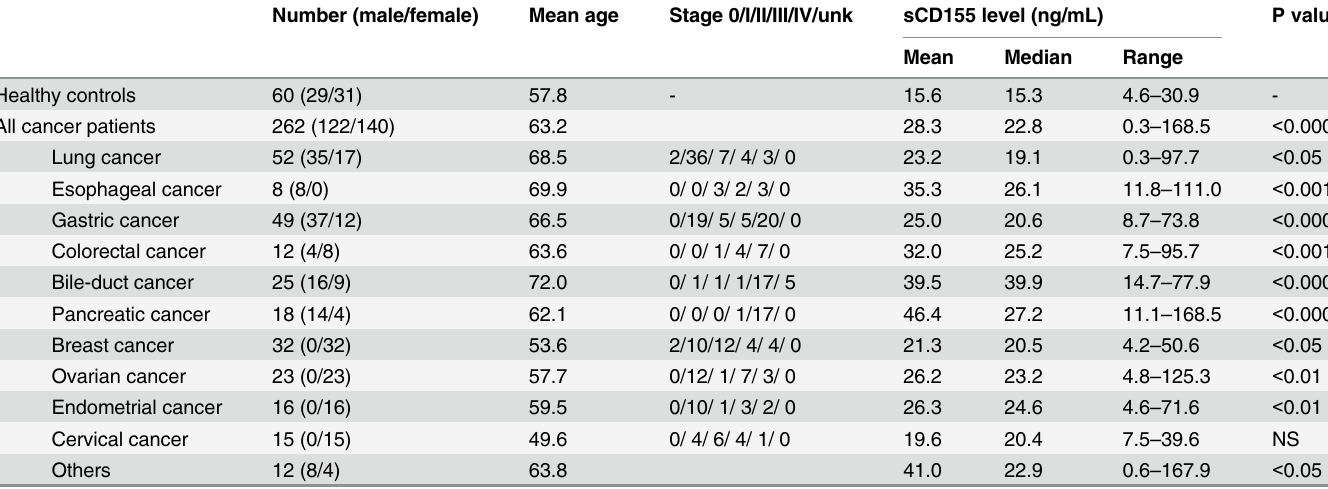
Table 1. Clinical parameters and level of sCD155 in healthy donors and cancer